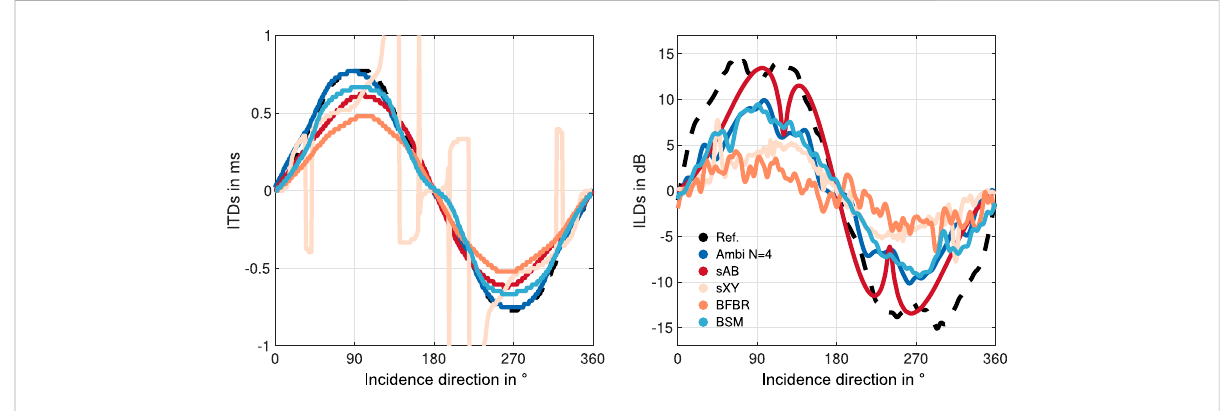
FIGURE 4 ITDs and ILDs of the EMA6 array using different binaural reproduction approaches. The reference values (black dashed lines) were calculated from the KU100